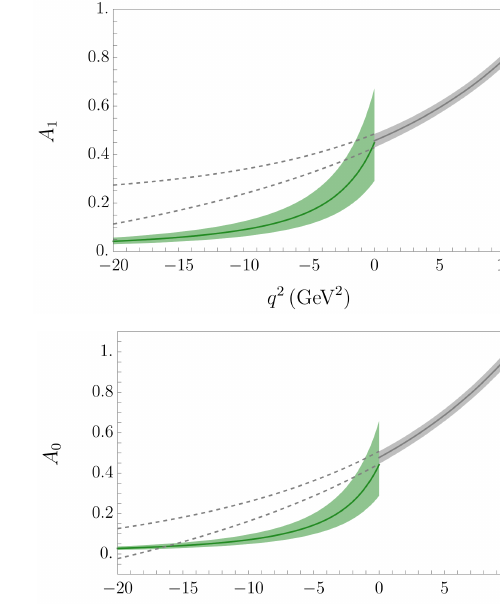
JHEP01(2023)032